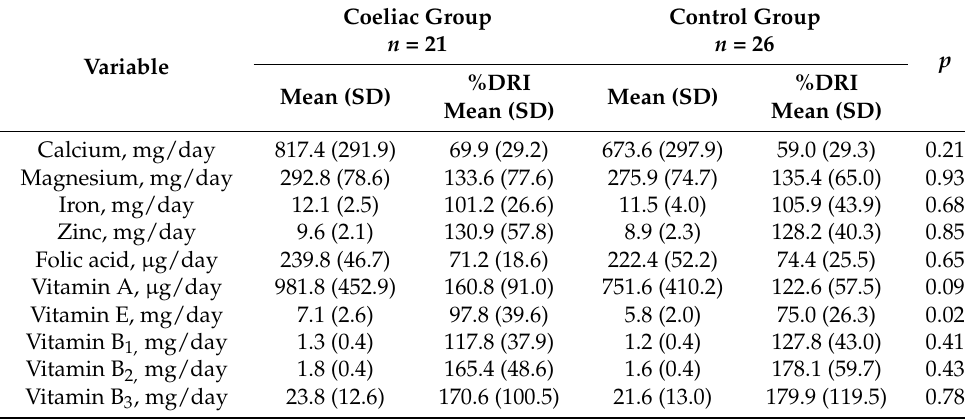
Table 9. Mean daily intake and percentage of dietary reference intake (%DRI) for micronutrients in CD and control